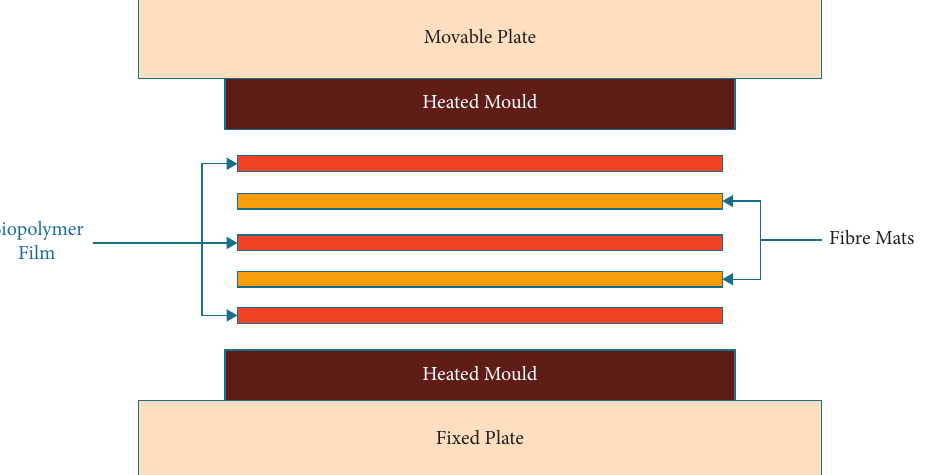
Figure 3: Schematic image of the compression molding technique.